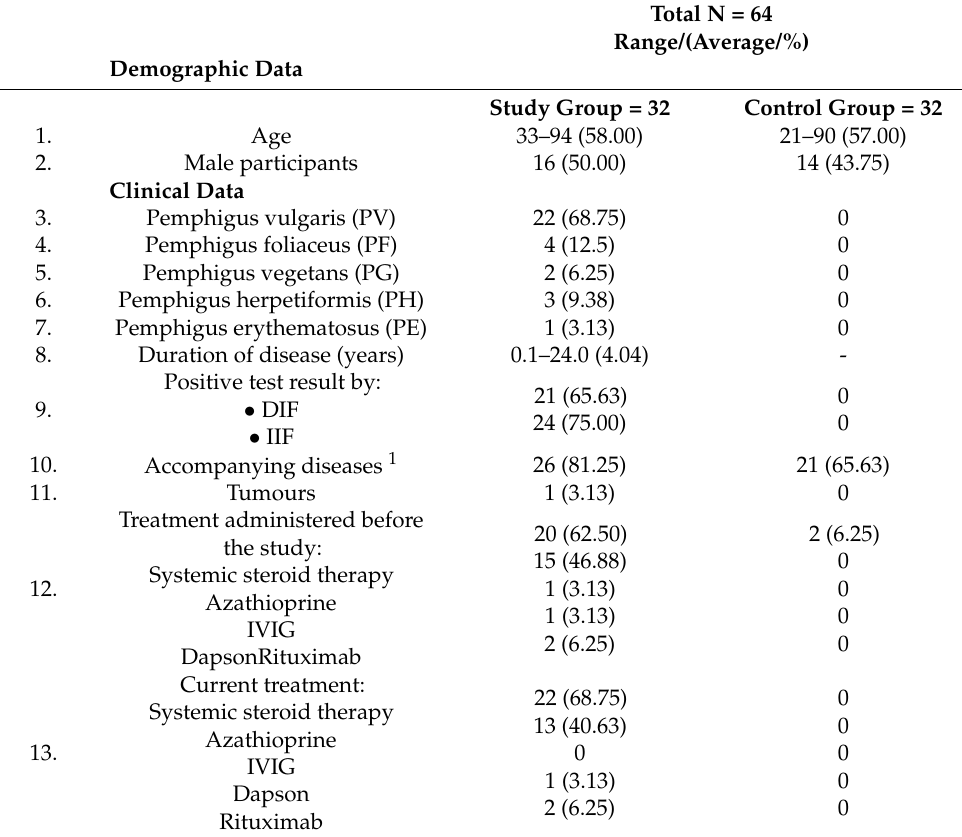
Table 1. Characteristics of the study group and the control